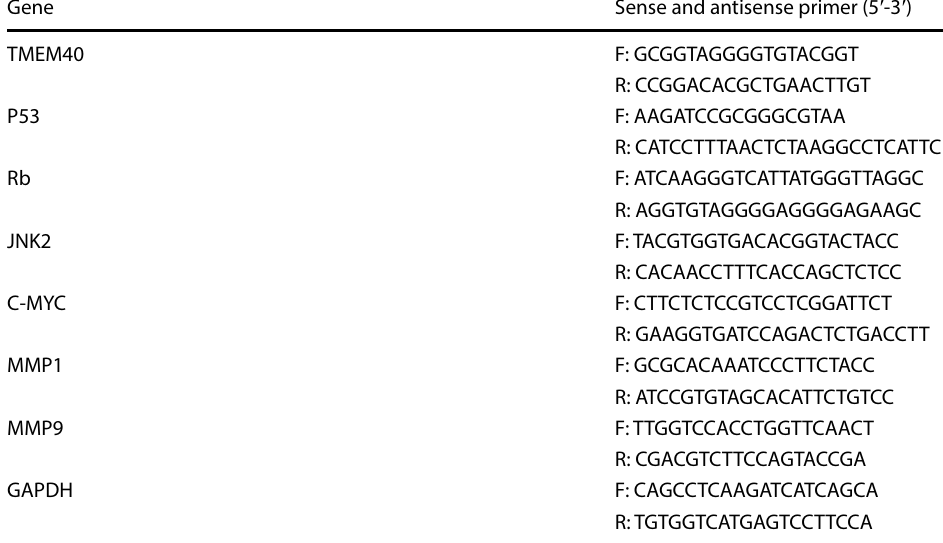
Table 3 The primers used in qRT-PCR